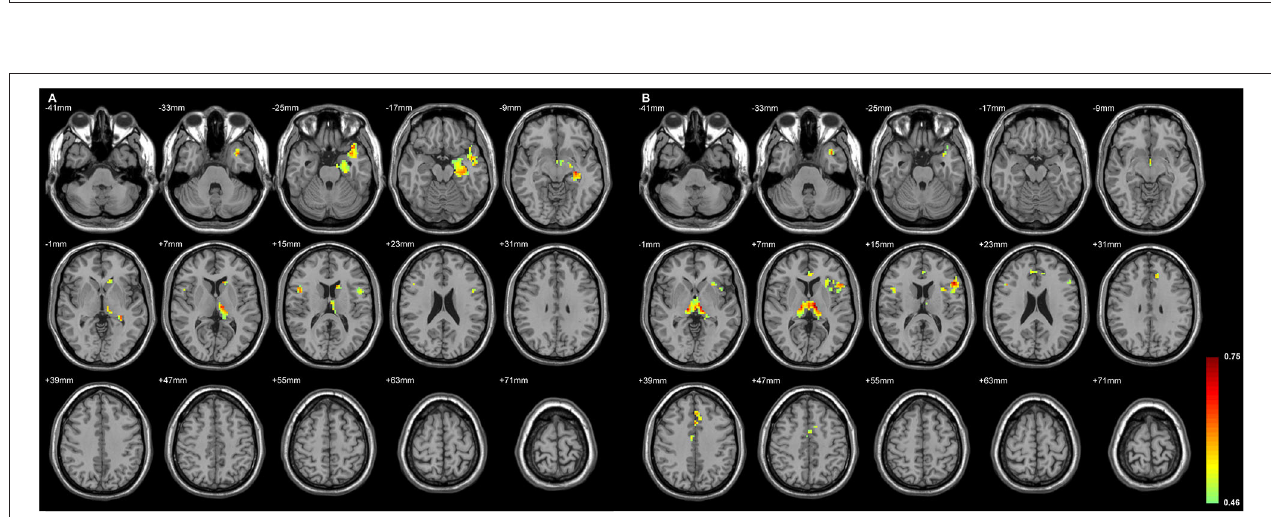
FIGURE 3 | The regions with their GMD related to the epilepsy duration. The longer duration was related to decreased GMD in both TLE. (A) The involved cortices in L-TLE were in the left temporal and right inferior frontal areas. (B) The involved cortices in R-TLE were in the right temporal and left cerebellar areas. Differences with a p < 0.01 were considered significant (with a threshold p < 0.01 and a minimum cluster size = 354 voxels, as determined by the AlphaSim correction).